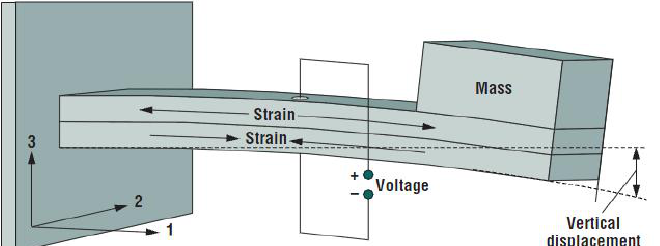
Figure 8. Rectangular cantilever beam ( © 2005 IEEE. Reprinted with permission from